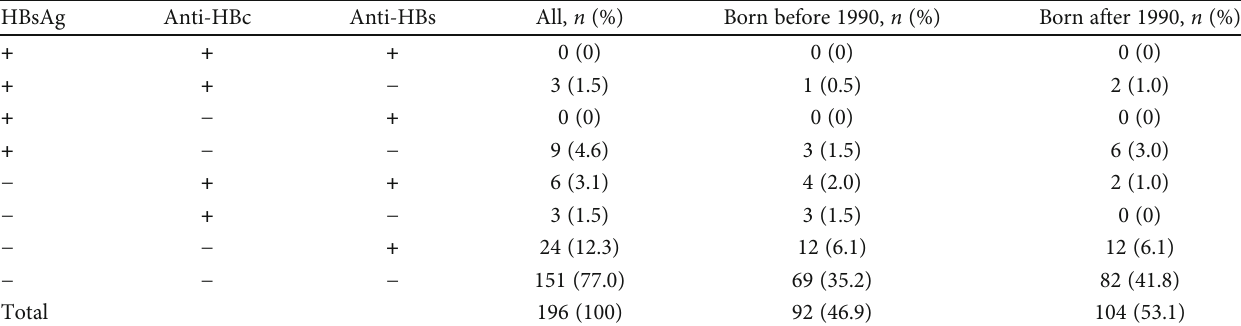
Table 2: Hepatitis B infection serological